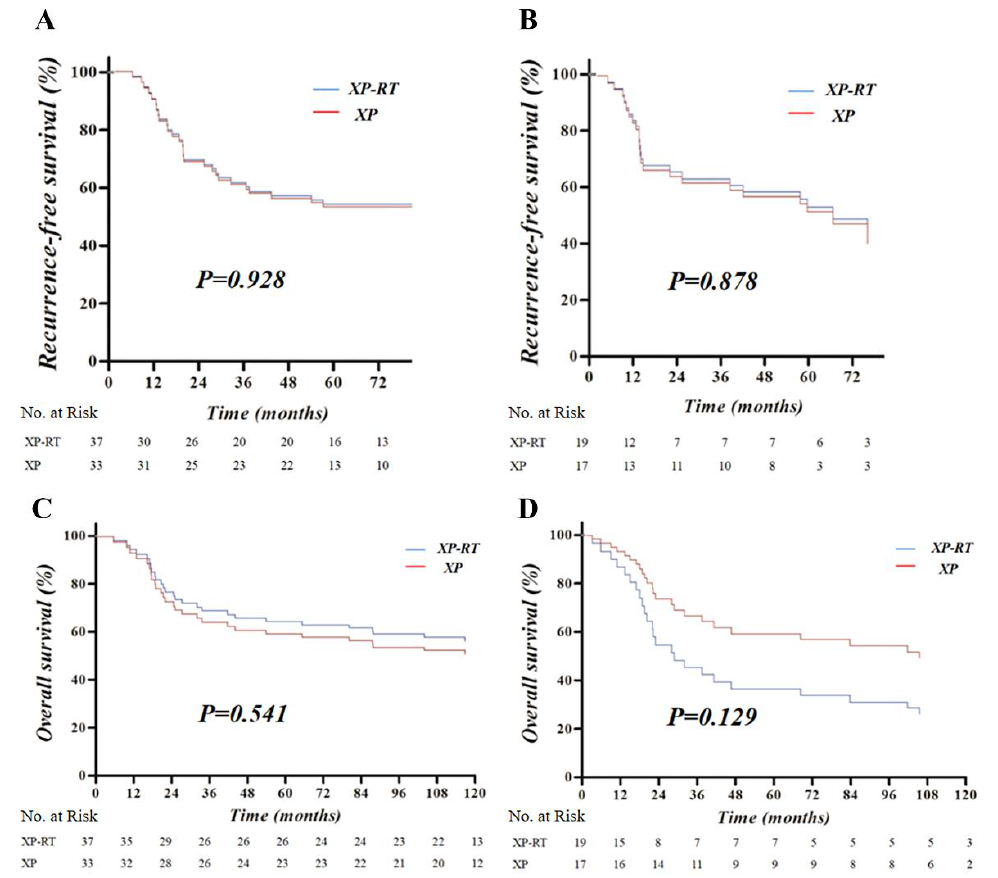
Figure 2. Adjusted curve of recurrence-free survival (RFS, A , B ) and overall survival (OS, C , D ) according to the use of adjuvant XP-RT or XP for the mesenchymal ( B , D ) and non-mesenchymal subtypes ( A , C ). In these curves which were displayed for the average value of the covariates in the study population, no significant differences related to the use of adjuvant XP-RT or XP were detected, although OS curves were inverted depending on adjuvant modality for the mesenchymal and non-mesenchymal subtypes (The presented p-values were based on HR test in the Cox proportional hazards model.).